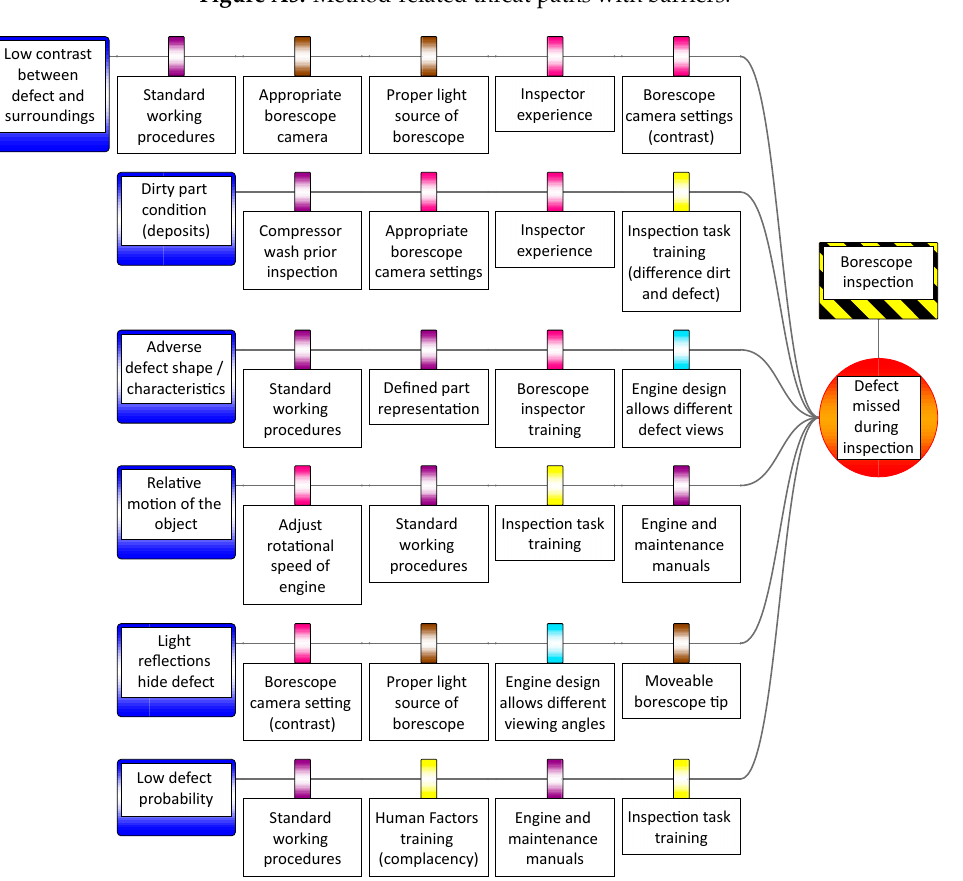
Figure A6. Material-related threat paths with barriers.